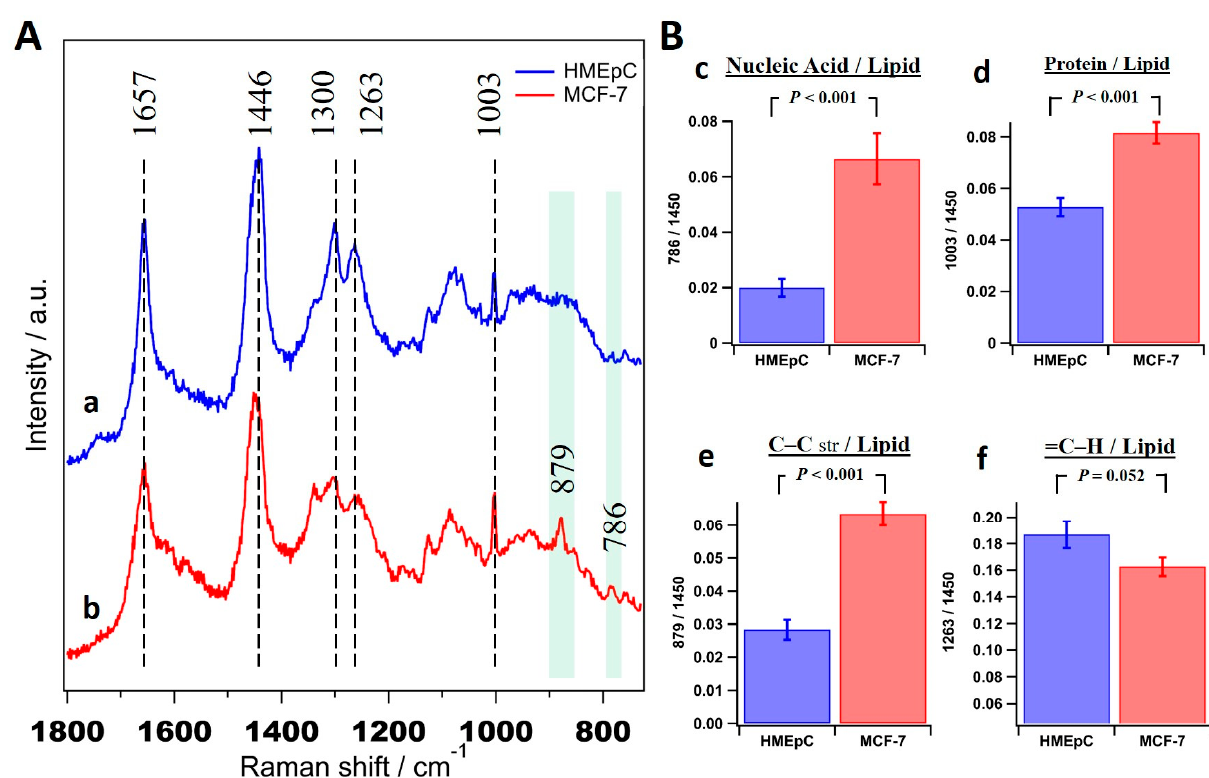
Figure 1. Comparison of average Raman spectra of MCF-7 and HMEpC. ( A ) Averaged Raman spectra ( ± S.D.) obtained from 30 cells of ( a ) HMEpC and ( b ) MCF-7, respectively. The consistent band positions were shown with broken lines and significant differences were highlighted by shaded bars. ( B ) Biomolecular ratios of ( c ) nucleic acid/lipid, ( d ) protein/lipid, ( e ) C–C str/lipid (chain lengths) and ( f ) =C–H/lipid (unsaturation).